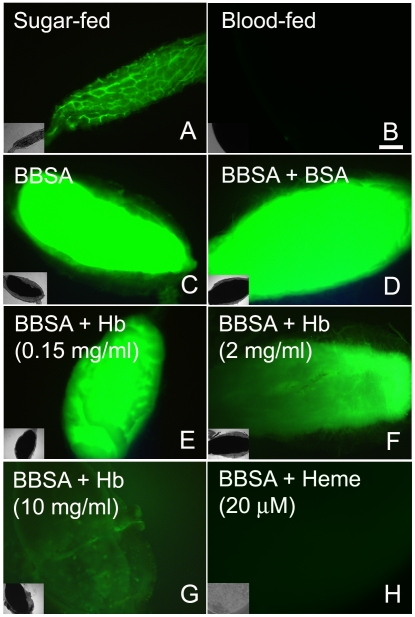
Heme is responsible for blood-induced ROS inhibition in the midgut.Female mosquitoes were fed different meals: (A) sugar; (B) blood (dissected immediately after meal); (C) BBSA alone; (D) BBSA + albumin (BSA) (50 mg/mL); (E–G) BBSA + hemoglobin; (H) BBSA + heme (20 µM). Midguts shown in panels B-H were dissected immediately after feeding. CM-H2DCFDA fluorescence is shown in all panels. Insets are differential interference contrast (DIC) images. Scale bar – 100 µm.